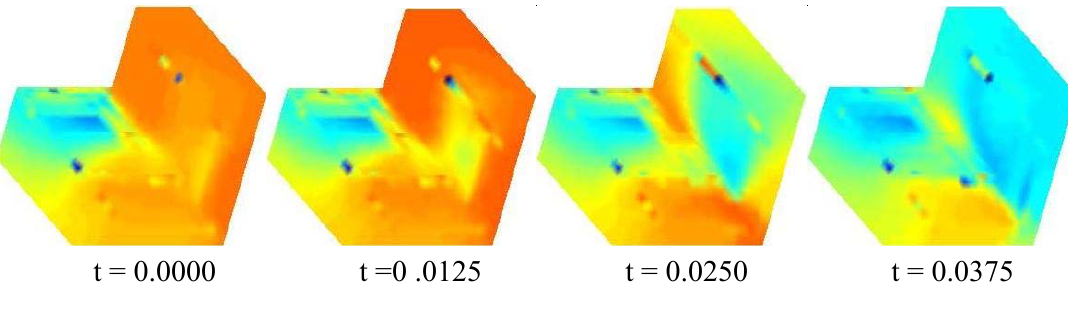
Figure 19. Snapshots of solids discharge in a 90 o bend by